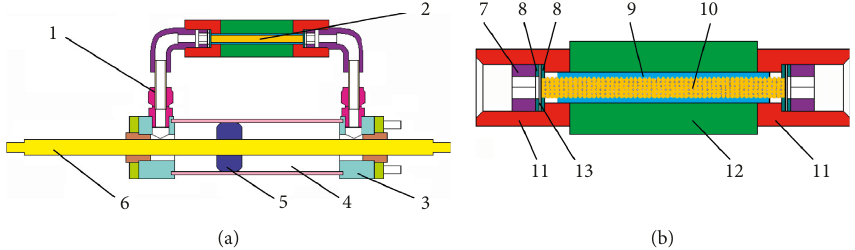
Figure 21: (a) Schematic configuration of the porous bypass-type MRF damper with external coil and (b) schematic of bypass valve. 1, tube and fittings; 2, bypass valve; 3, end block; 4, MRF chamber; 5, piston; 6, rod; 7, hollow set hex screw; 8, nylon washer; 9, nonmagnetic stainless steel tube; 10, magnetic stainless steel spheres; 11, steel end cap; 12, copper solenoid; 13, steel mesh [69, 70]. Straight with Spiral Spiral with beads beads